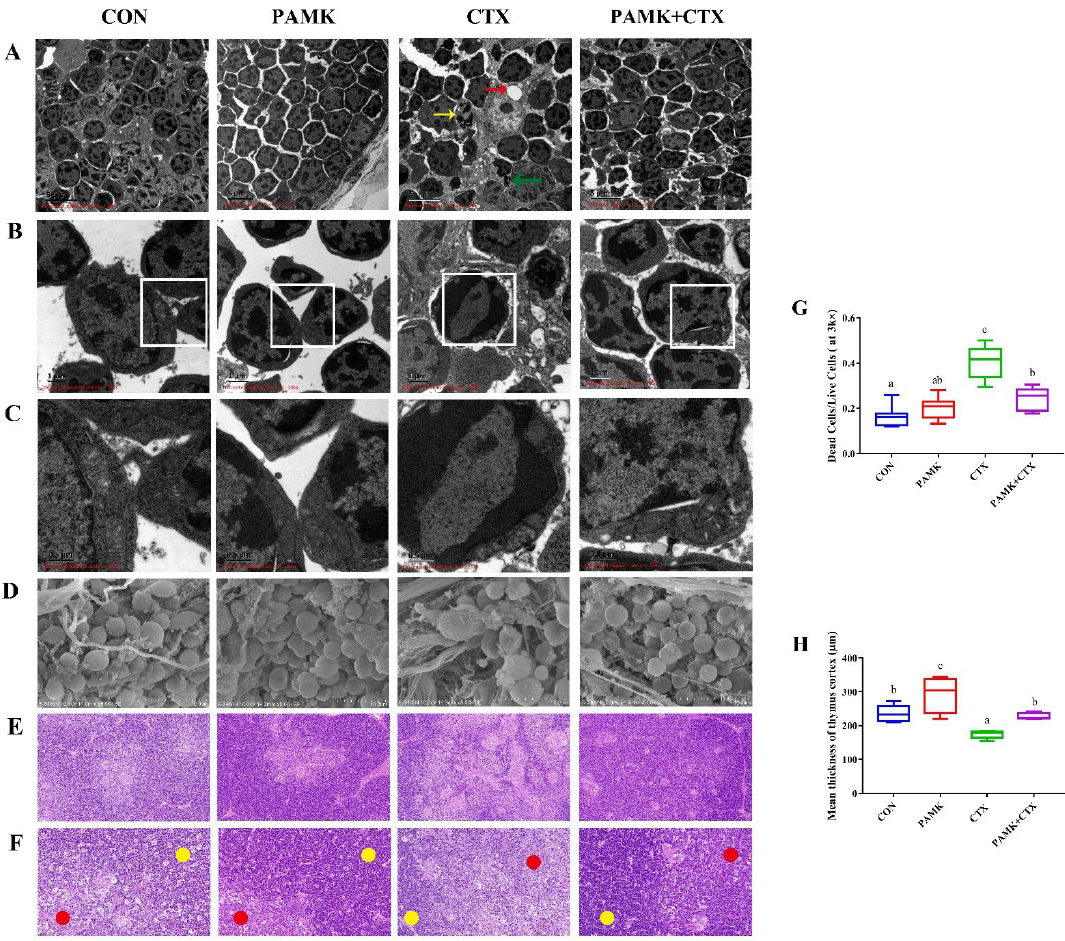
Figure 3. Effects of PAMK on histology and the ultramicroscopic morphology of thymus treated with CTX. ( A ) Transmission electron microscopy (TEM; 3000 × ) of the thymus. The red arrows indicate cell cavity; the yellow arrows indicate apoptotic cells; the green arrows indicate the apoptosis body. ( B ) Transmission electron microscopy (TEM; 10,000 × ) of the thymus. ( C ) Transmission electron microscopy (TEM; 30,000 × ) of the thymus. ( D ) Scanning electron microscopy (SEM; 5000 × ) of the thymus. ( E ) HE staining of the thymus (200 × ). ( F ) HE staining of the thymus (600 × ); red circles indicate the thymic medulla; yellow circles indicate the thymic cortex. ( G ) Ratio of dead cells to live cells in a single field of view at SEM (3000 × ); ( H ) Quantification of the mean thickness of the thymic cortex. Data are expressed as min to max, n = 3. Different letters indicate p < 0.05, significantly